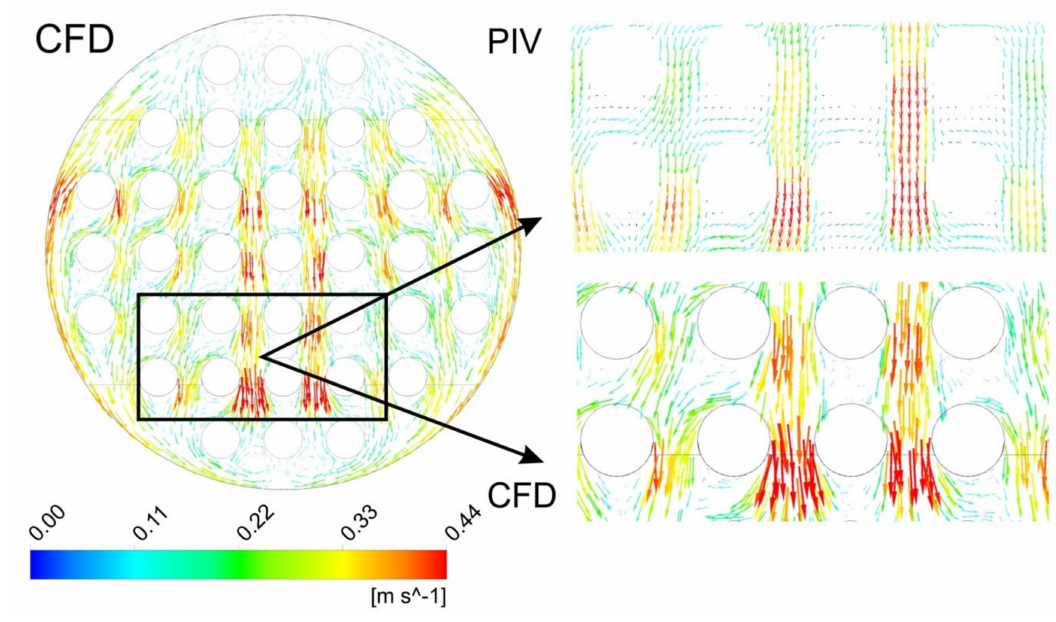
Figure 17. Sample comparison of vector velocity fields PIV and CFD for flow rate Q = 7.5 m 3 /